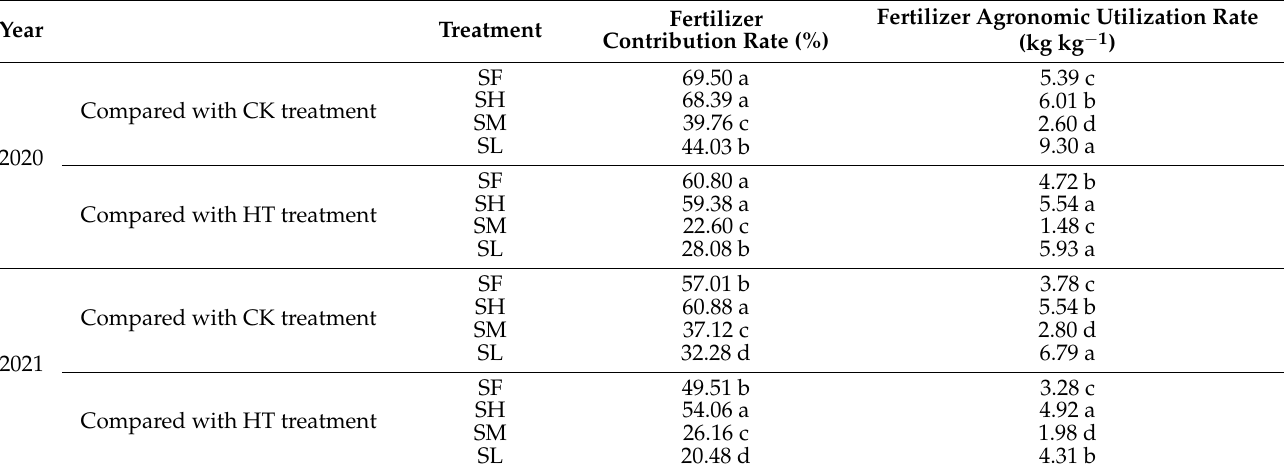
Table 8. Effect of rice straw combined with inorganic fertilizer on fertilizer